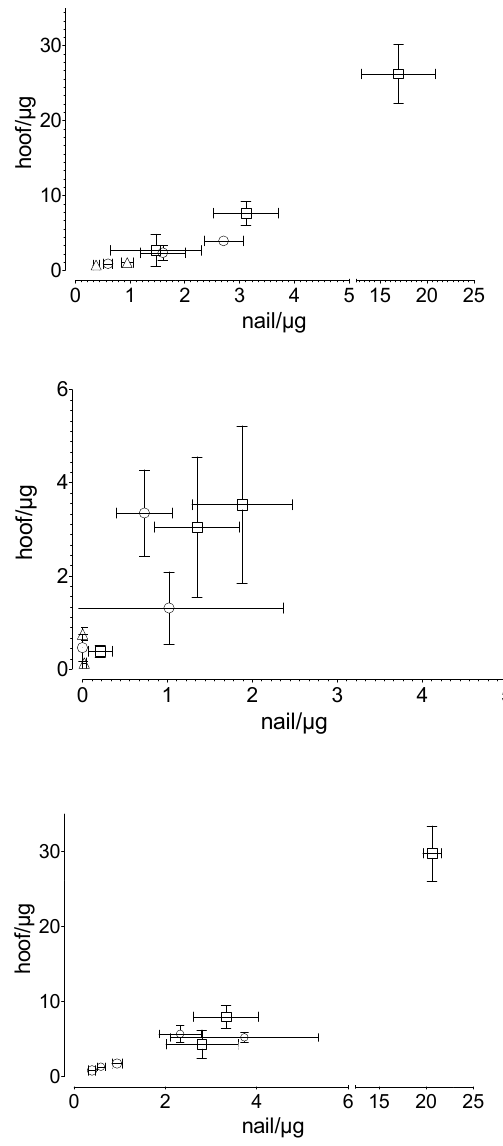
Figure 6. Correlation between human nail and equine hoof membranes in terms of ( top ) the pene- trated (R 2 : 0.985), ( middle ) the permeated (R 2 : 0.616), and ( bottom ) the total drug uptake (R 2 : 0.986) drug amount, considering the experimental time and the applied drug amount: # caffeine, ￿ sorbic acid, and △ testosterone. Mean value ± standard deviation, n = 6.